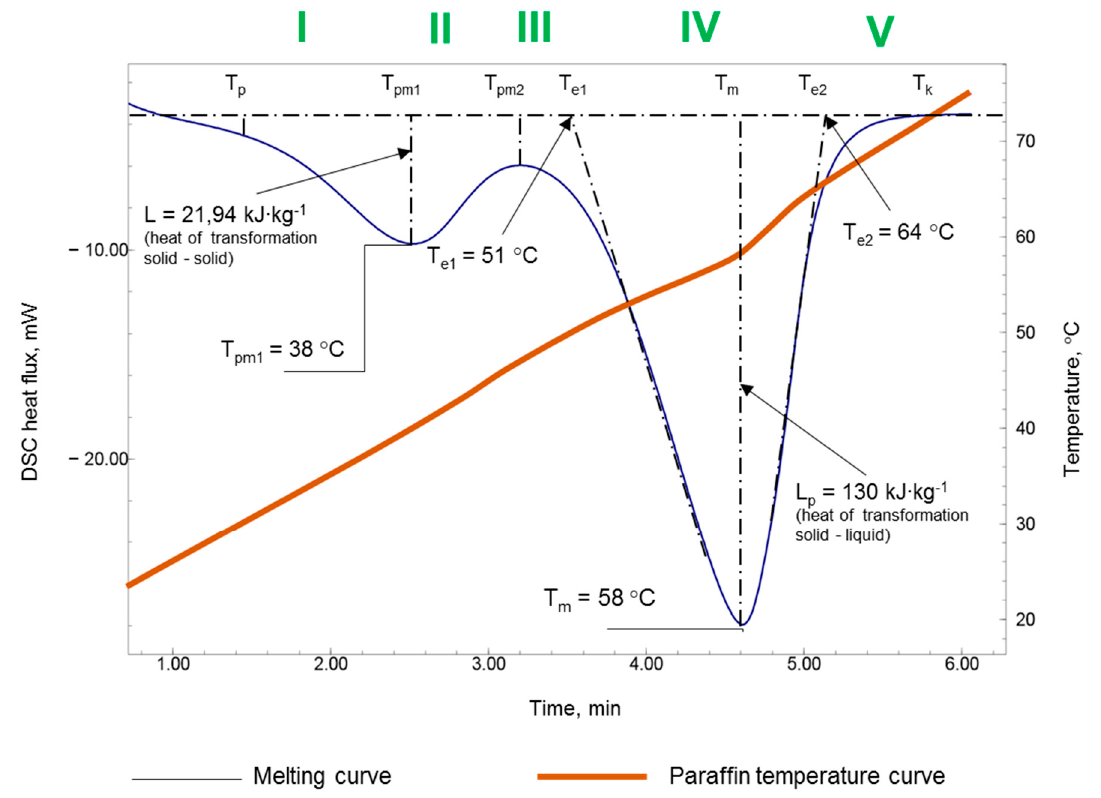
Figure 4. The DSC phase change curve for the tested material—R58 paraffin.